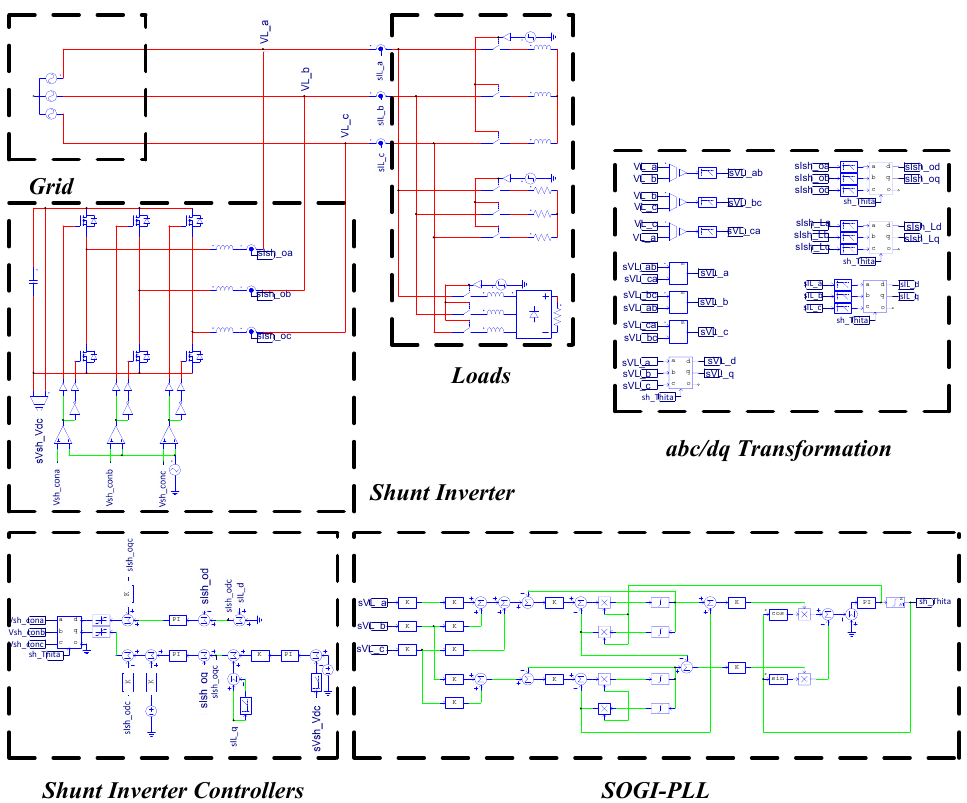
Figure 10. Powersim (PSIM) simulation model of the proposed APF system.